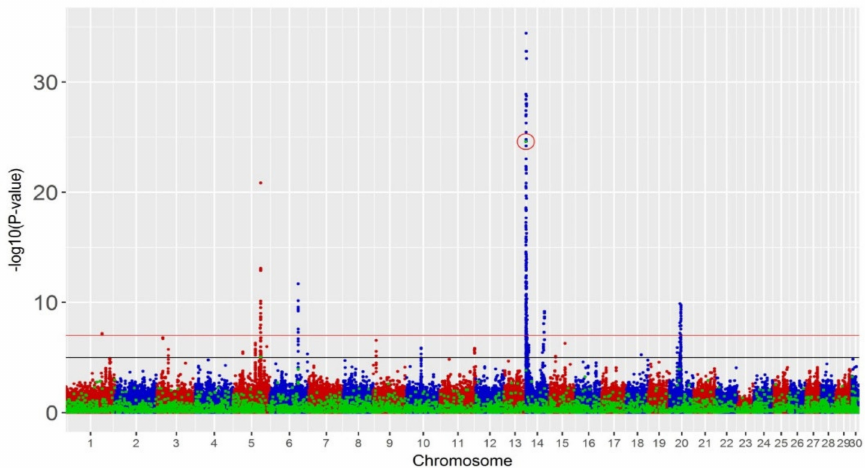
Figure 2. Manhattan plots of meta-analyses of single traits: (top panel) milk yield, (middle) fertility and (bottom) overall type with − log10( p -value) on vertical axis and chromosome number on hori- zontal axis. Red line is the threshold of p -value 10 − 7 and black line is the threshold of p -value 10 − 5 . Blue and red spots represent SNP markers and green spots represent SV markers. Significant SVs with p -value < 10 − 7 are circled in red.